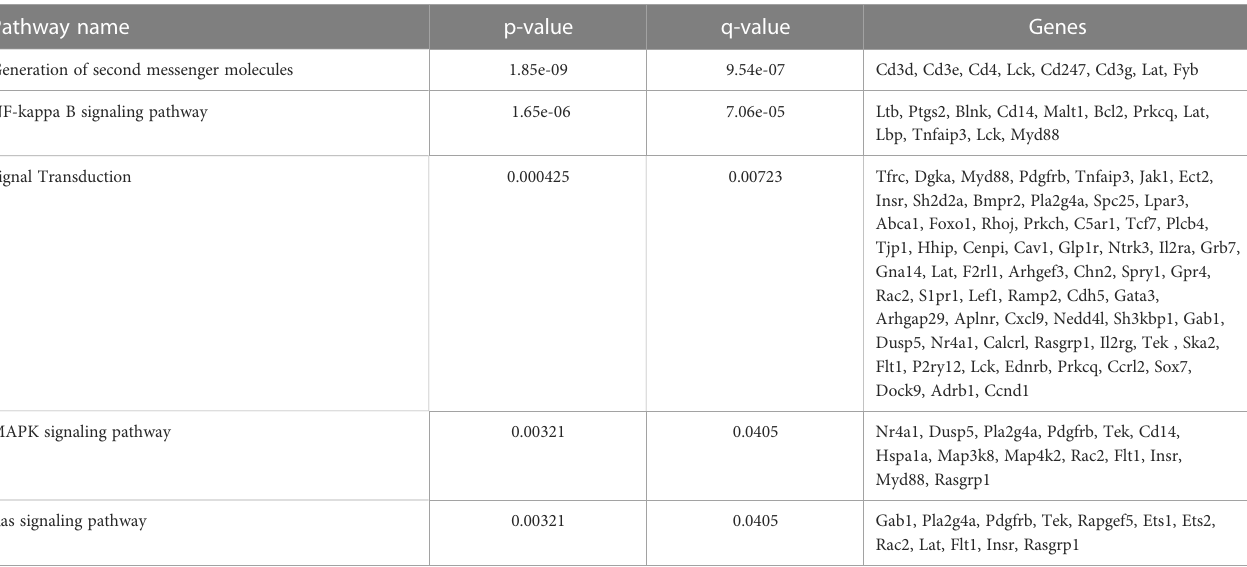
TABLE 2 CD103+ DCs selected overrepresented